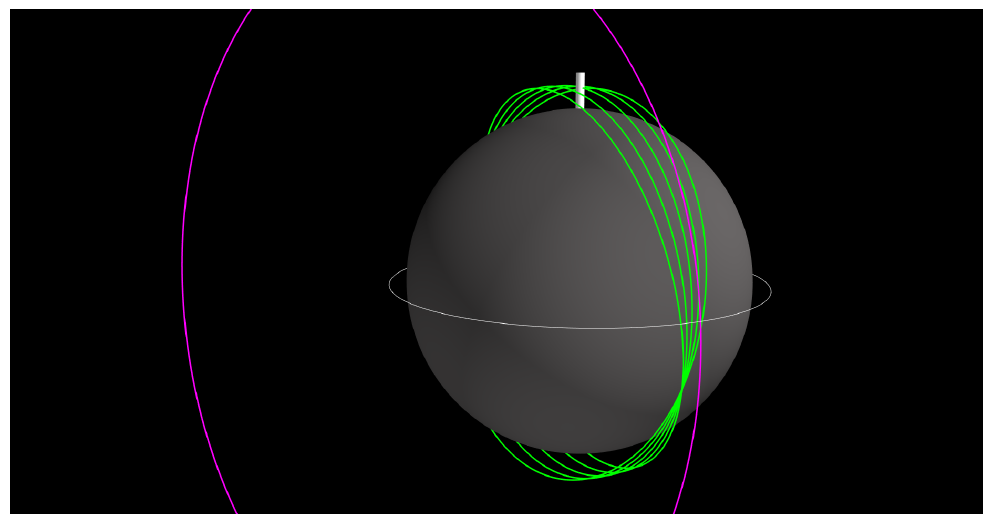
Figure 31. Venus small satellite constellation in 200 × 2000 km near-polar inclination orbits (green), and the host orbiter in a 250 × 150,000 km polar orbit (magenta).